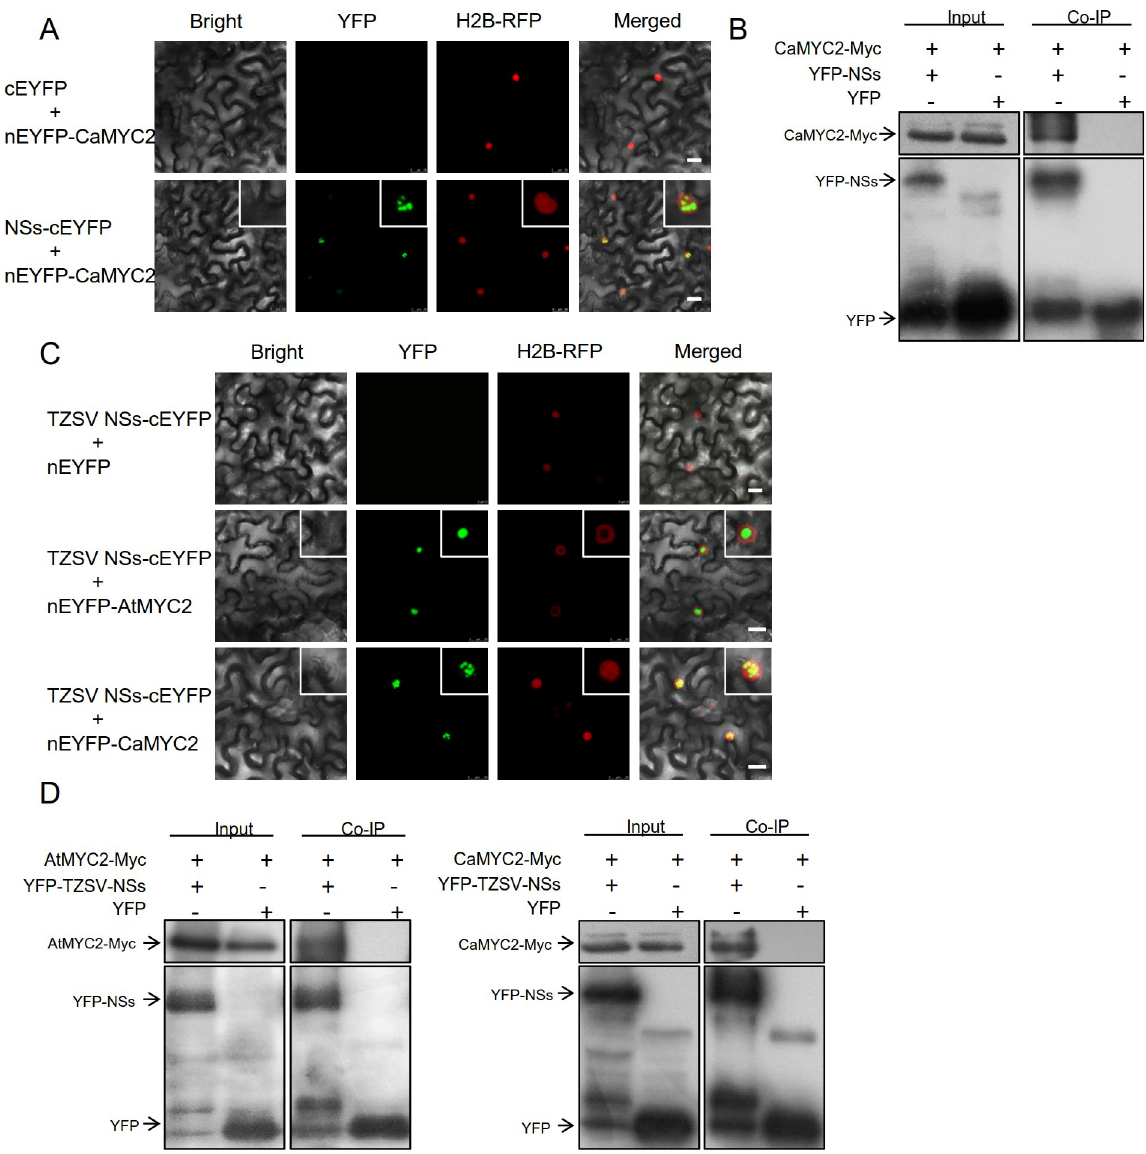
Fig 7. A conserved protein interaction between Orthotospovirus NSs and plant MYC2 proteins. (A) BiFC assays of the interaction between TSWV NSs and CaMYC2. H2B-RFP transgenic N . benthamiana plants, which express a nucleus marker were used in this assay. Bars = 15 μ m. (B) Co-immunoprecipitation (Co-IP) assay of the interaction between TSWV NSs and CaMYC2. GFP-trap beads were used to precipitate the interaction complex. (C) BiFC assays of the interaction between TZSV NSs–AtMYC2 and TZSV NSs–CaMYC2. H2B-RFP transgenic N . benthamiana plants were used in this assay. Bars = 15 μ m. (D) Co-immunoprecipitation (Co-IP) assay of the interaction between TZSV NSs– AtMYC2 (left panel) and TZSV NSs–CaMYC2 (right panel). GFP-trap beads were used to precipitate the interaction complex.